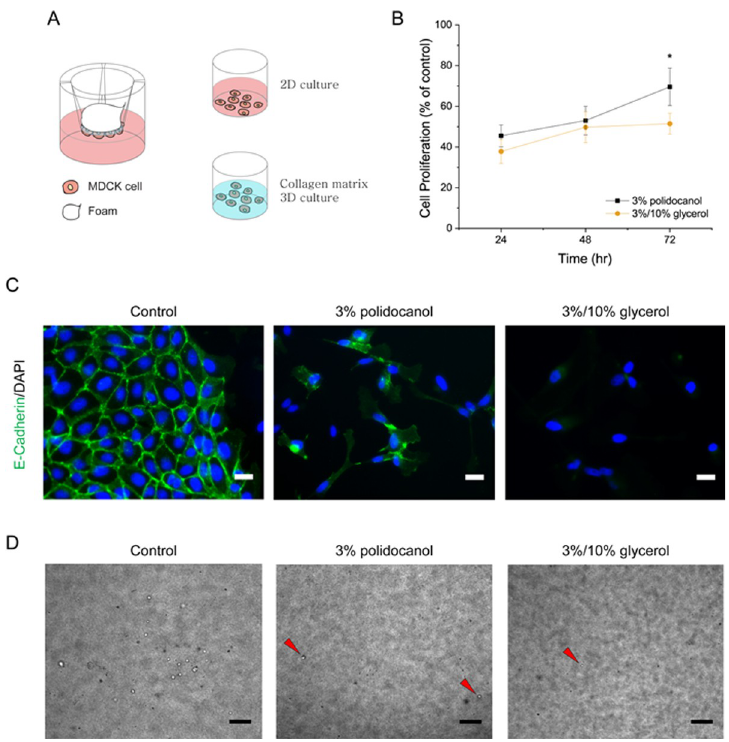
Fig 4. Glycerol in polidocanol foam attenuates proliferation and E-cadherin expression. (A) Scheme for in vitro foam analysis. After the foam treatment, the viable cells were collected and re-plated for proliferation and protein expression analysis. (B) The cell proliferation graph shows the augmented foam-treated cells proliferated slower compared to the polidocanol foam-treated cells. (C) Protein expression 3 days after cell re-plating. Augmented foam- treated cells failed to form a visible e-cadherin junction like the polidocanol-treated cells. (D) MDCK cells after 3D re- plating showed less cyst generation and a smaller cyst. (Scale bar = 200 μ m).